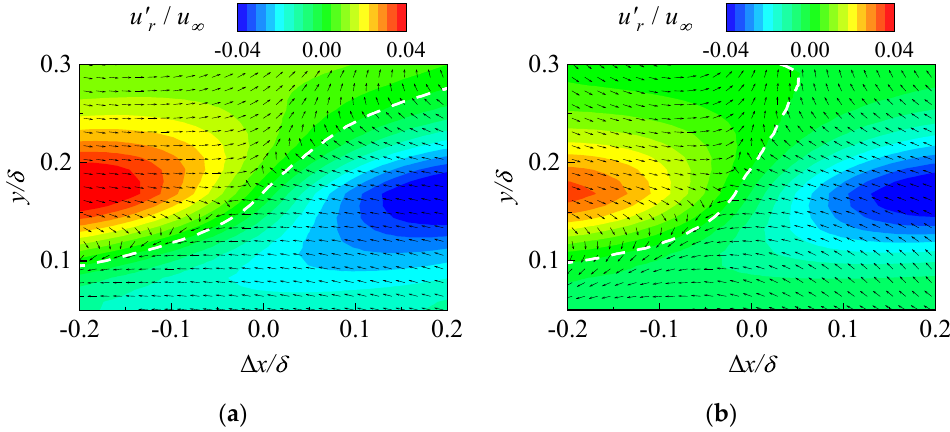
Figure 17. Conditional average results of shear layer: ( a ) None; ( b ) Control.